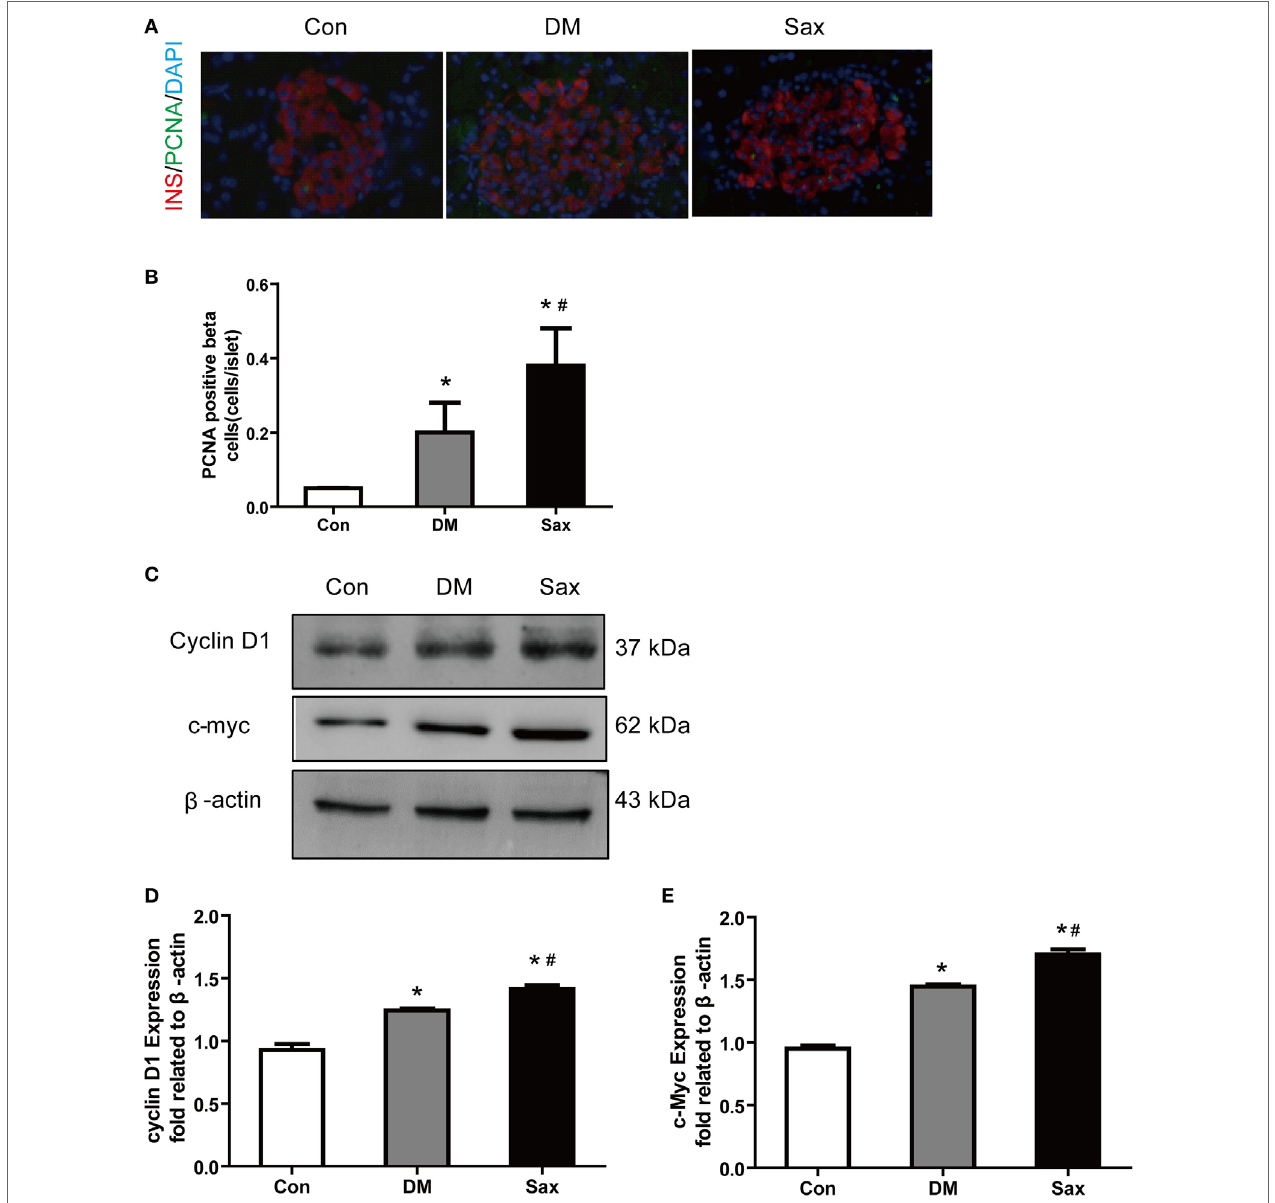
FigUre 3 | Effects of saxagliptin on β -cell proliferation in high-fat diet/STZ-induced diabetic rats. Representative pancreas sections of PCNA and insulin double immunofluorescence staining merged images from con, DM, and Sax group, insulin (red), PCNA (green), DAPI (blue) (a) and the positive β -cell proliferation numbers (b) . Western blot analysis for protein expression of c-myc and cyclin D1 in isolated islets of rats (c) . Densitometric analysis of indicated protein expression (D,e) . n = 4 rats for each group. Data were reported as mean ± SEM. * p < 0.05 compared with the control group, # p < 0.05 compared with DM group. Con, control; DM, diabetes; Sax,